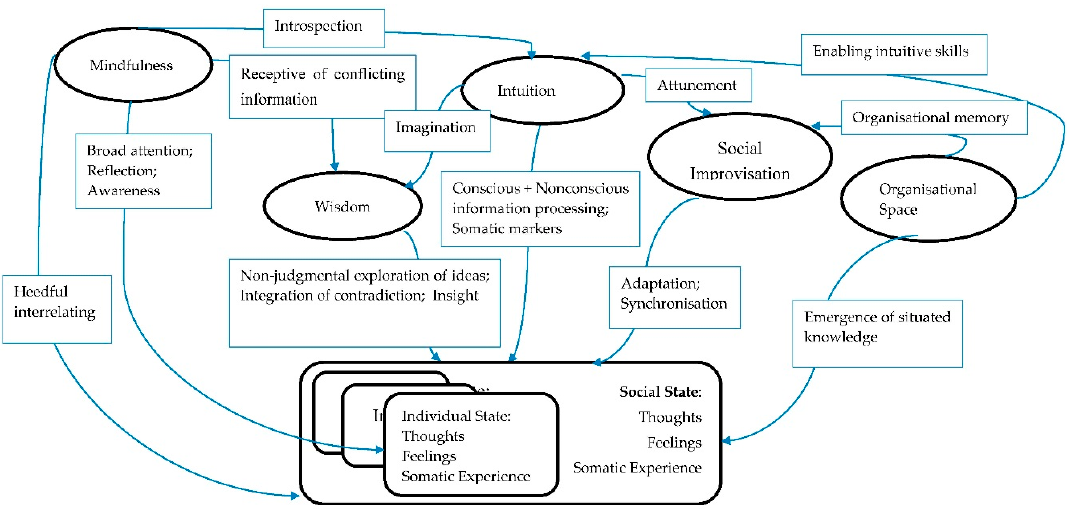
Figure 1. A framework for integrating five non-rational perspectives impacting decision-making states.